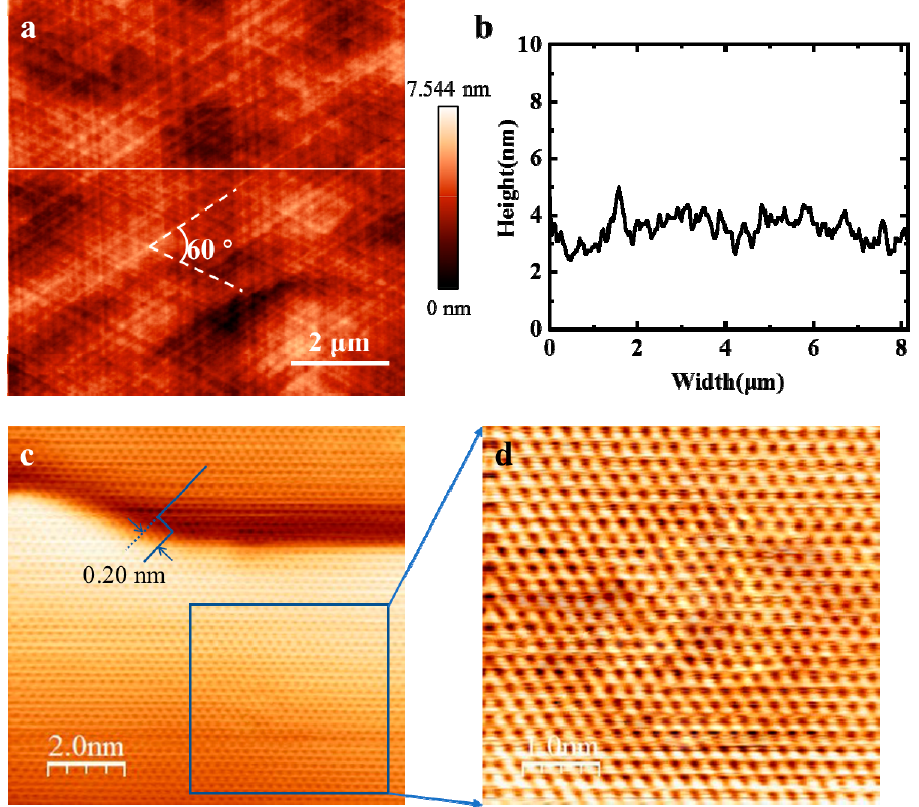
Figure 4. Microstructure characterization of graphene grown on Ni (111) film at 950 °C . ( a ) The AFM image of graphene grown on Ni (111) with an average roughness of 0.64 nm. ( b ) A profile of apparent height in the AFM image along the white line marked in ( a ). ( c ) STM image of graphene on the Ni (111) surface with an atomic metal step measured under a tunneling current of 1 nA and bias of 100 mV at room temperature. ( d ) High-resolution STM image of graphene on a Ni (111) terrace marked as the rectangular box in ( c ).